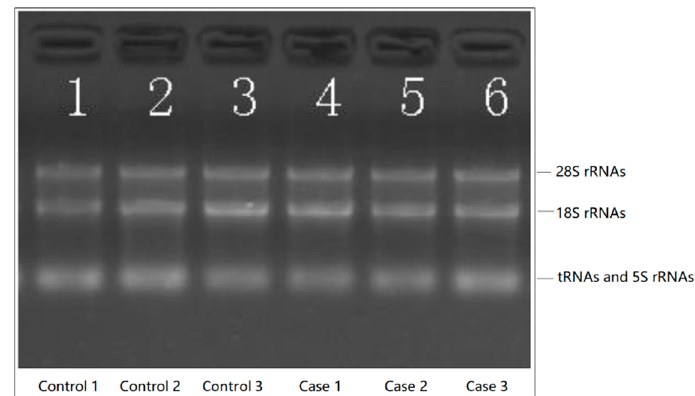
Figure 1. RNA integrity and genomic DNA contamination examined by denaturing agarose gel